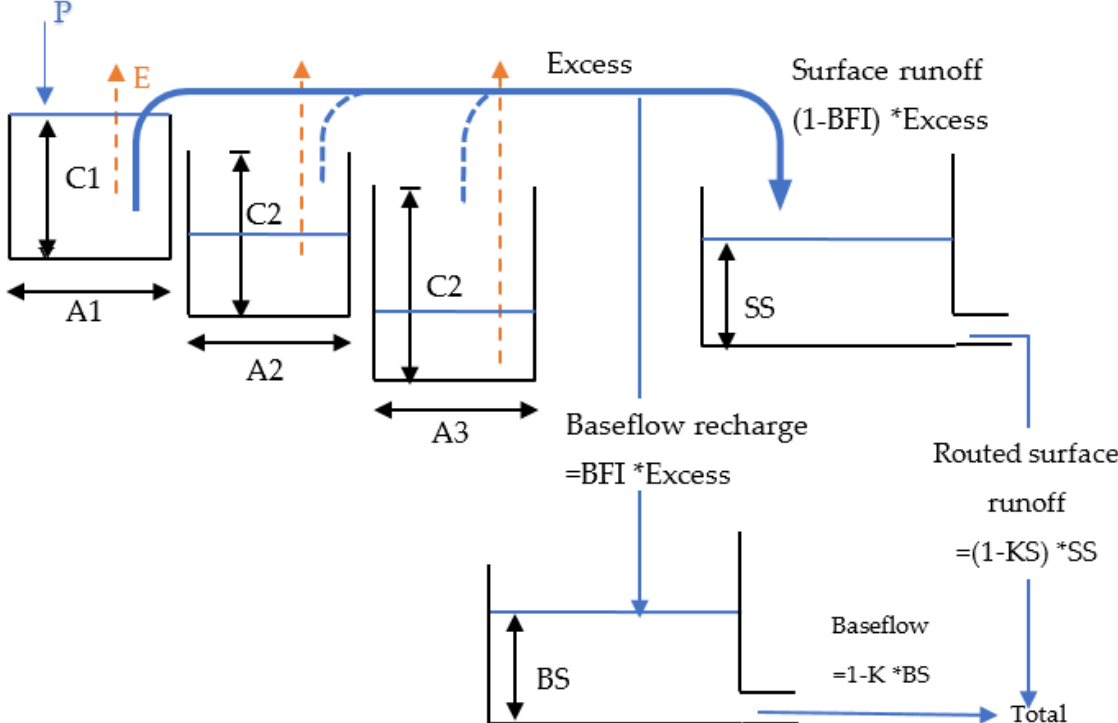
Figure 3. The AWMB description and structure to simulate runoff. Table 2. Parameters of the AWBM and their ranges.